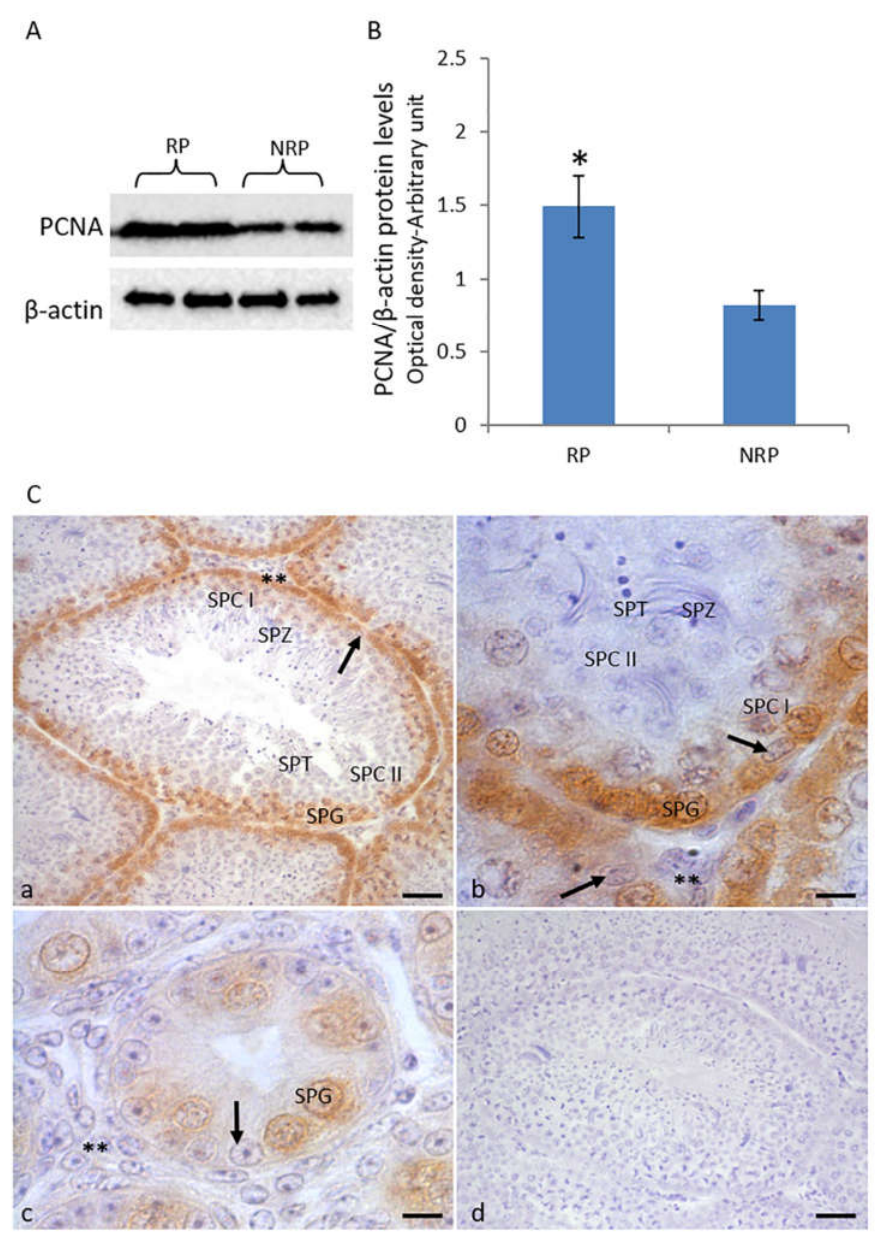
Figure 3. ( A ) Western blot analysis of testicular PCNA expression in quail during reproductive and non-reproductive periods. A specific band of 36 kDa was detected. ( B ) The amount of PCNA was quantified using the ImageJ program and normalized with respect to β -actin. The values pre- sented represent the means ± S.D. of the values obtained for five samples (two bands were shown). * p < 0.05. RP, reproductive period; NRP, non-reproductive period. ( C ) Immunohistochemical local- ization (brown areas) of PCNA. ( a , b ) Reproductive period. The signal is evident in spermatogonia (Spg), spermatocytes I (Spc I), and Sertoli (arrow) cells. No signal is evident in Leydig cells (**), spermatocytes II (Spc II), spermatids (Spt), and spermatozoa (Spz). ( c ) Non-reproductive period. The signal is evident only in spermatogonia (Spg). No positivity was detected in Leydig cells (**) and Sertoli cells (arrow). ( d ) Control section. Scale bars correspond to 5 µ m in ( a , c , d ) and 10 µ m in ( b ).